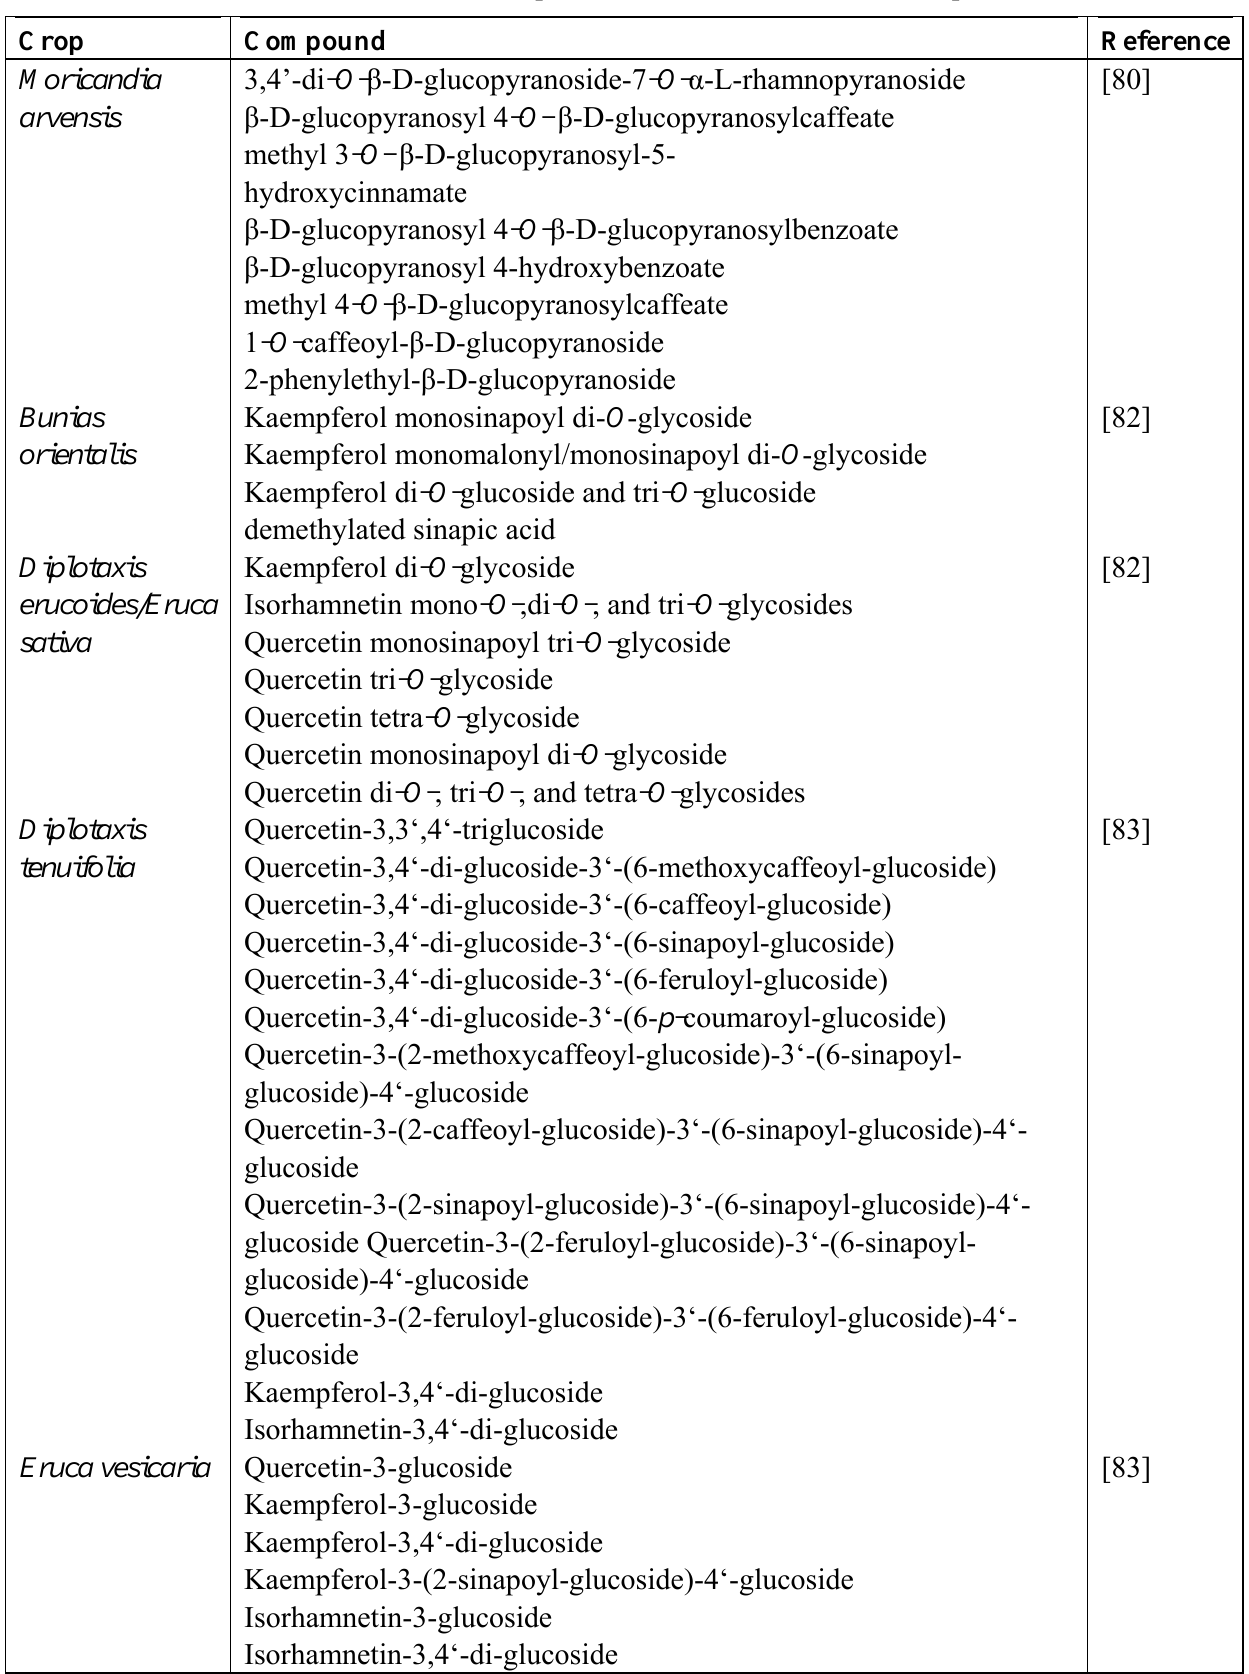
Table 3. Phenolic compounds in different cruciferous